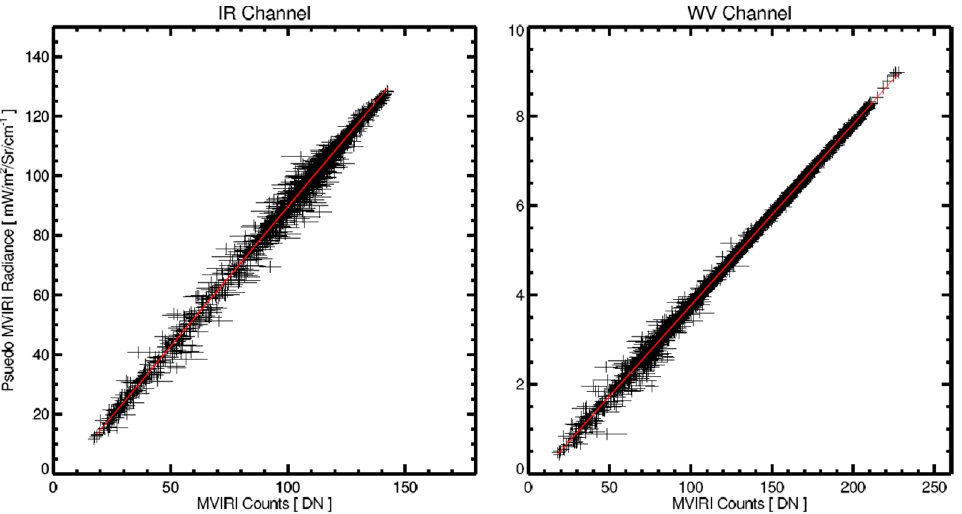
Figure 6. Regression between MVIRI measured counts and pseudo-MVIRI radiances computed from collocated IASI spectra, which were used to compute calibration coefficients. Errors in both the counts and pseudo-radiances were used to compute the linear fit (red line) parameters. Calibration coefficients were computed per day by collating 5 days of matchups (±2 days).